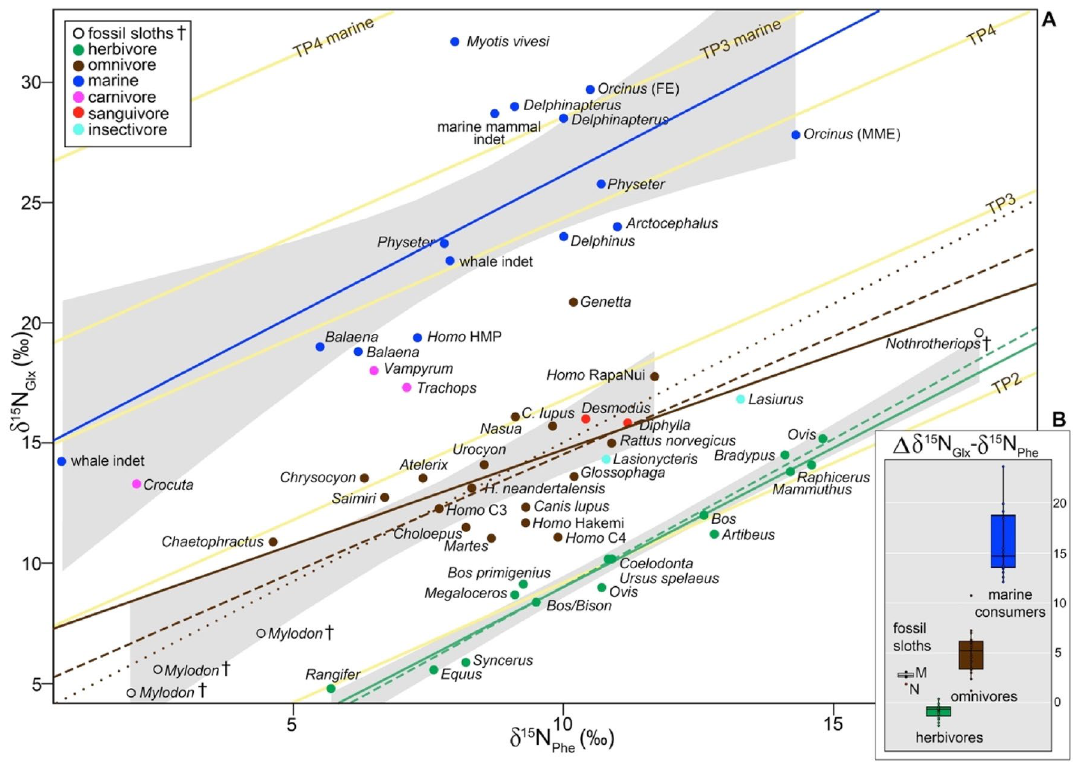
Figure 1. Scatter plot of δ 15 N Glx and δ 15 N Phe ( A ) and ∆δ 15 N Glx − δ 15 N Phe ( B ) for mammals, separated by feeding ecology categories. ( A ) Regression lines plotted for: modern herbivores (n = 15, solid green line, R 2 = 0.96, p < 0.001); modern herbivores + fossil Nothrotheriops (dashed green line, R 2 = 0.96, p < 0.001); modern wild omnivores (i.e., excluding zoo anteaters, n = 18) (solid brown line, R 2 = 0.28, p = 0.03), modern omnivores + both fossil sloth species (dashed brown line, R 2 = 0.68, p < 0.001), modern omnivores + fossil Mylodon (while excluding the two outliers of this regression Nothrotheriops and Genetta [determined by robust regression and diagnostic analyses], dotted brown line, R 2 = 0.71, p < 0.001). Grey shading is the standard error, including Mylodon with omnivores and Nothrotheriops with herbivores. Yellow lines represent theoretical trophic levels from the TP equations by 20 . Notice that except for primary consumers (TP = 2), the theoretical trophic levels obtained from those equations do not match the known feeding ecologies for mammals in higher trophic levels. Data used for this figure comes from this study and a thorough literature compilation (Table S6). ( B ) M = Mylodon , N = Nothrotheriops .